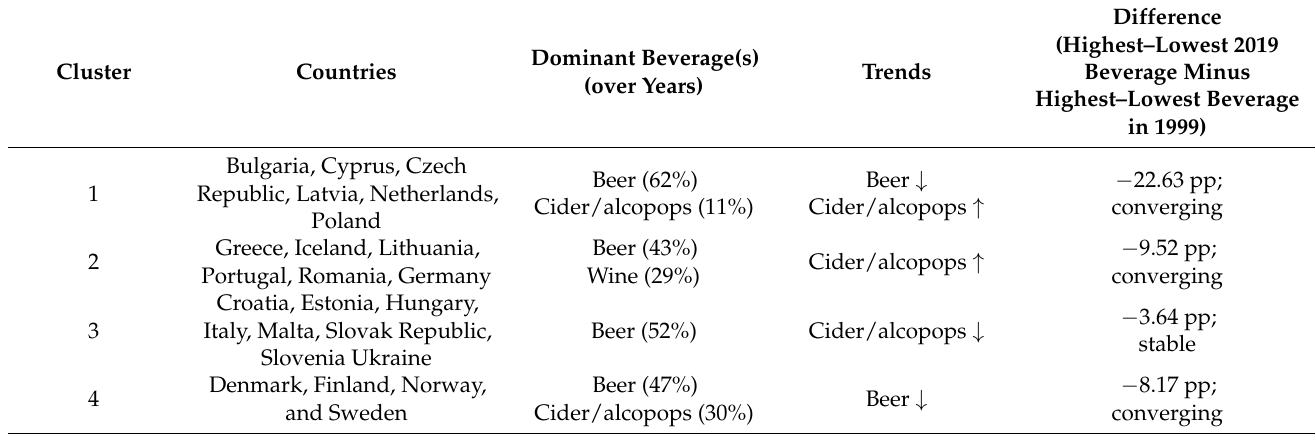
Table 2. Clusters by country, dominant beverage(s), trends, and difference between highest–lowest 2019 and highest–lowest in 1999 for boys.